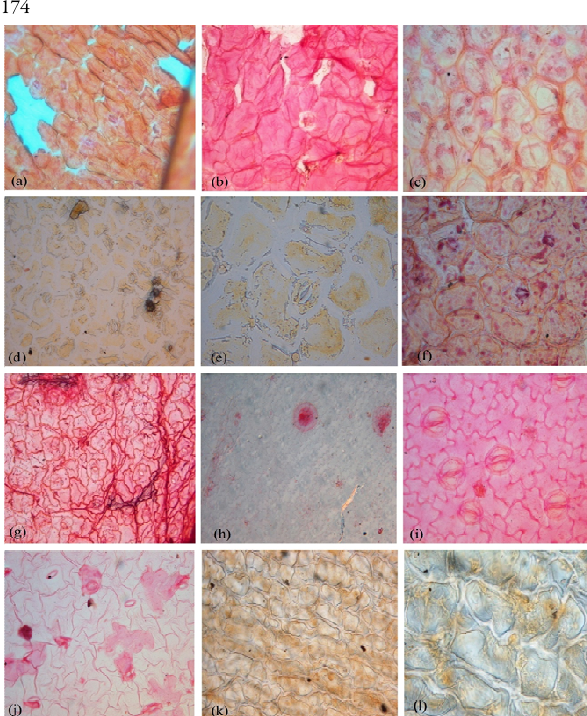
Fig. 2. a. Trifolium repens ; b. Pedicularis bicornuta ; c. Corydalis crassifolia ; d. Epilobium latifolium (Cells); e. Epilobium latifolium (Stomata); f. Oxyria digyna ; g. Draba amoena ; h. Thymus serpylium ; i. Anemone s pp . ; j. Gentianella paludosa ; k. Meconopsis aculeate (Cells); l. Meconopsis aculeate (Stomata)